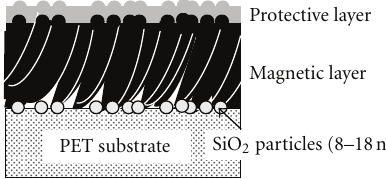
Figure 19: Schematic diagram of the cross section of a magnetic